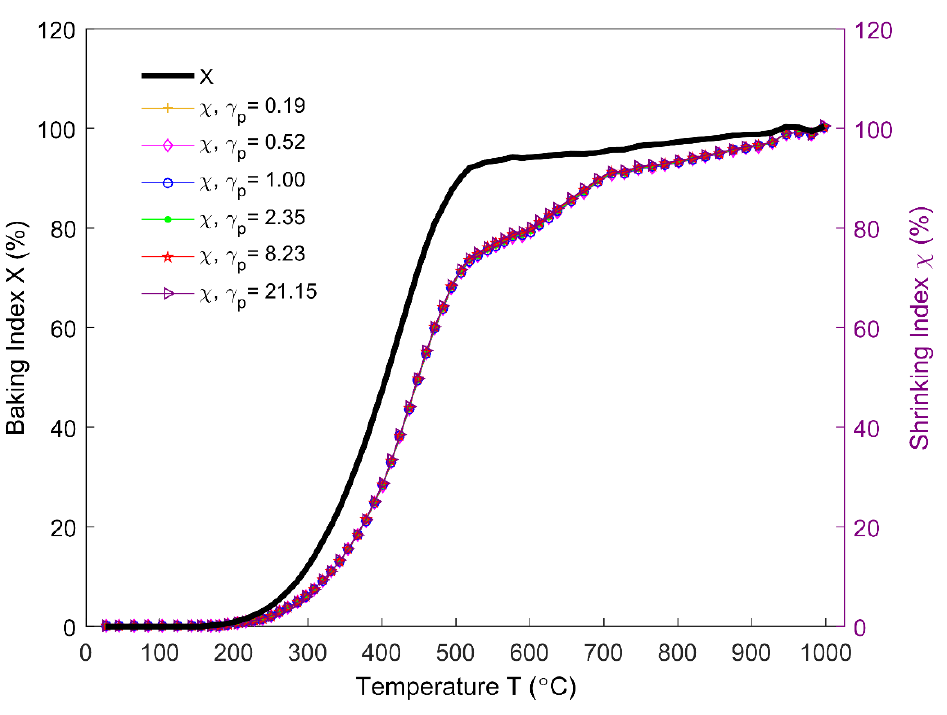
Figure 20. Baking index and shrinking index for different permeability correlators.